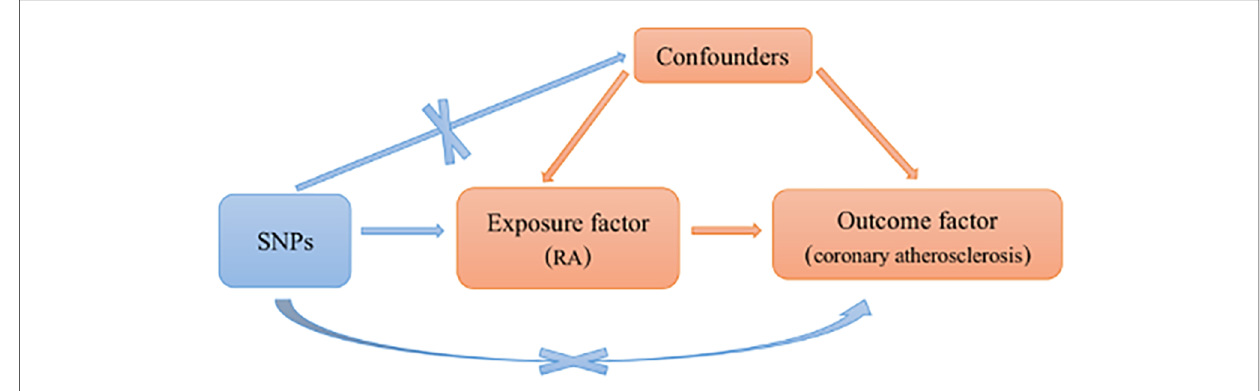
FIGURE 1 Schematic representation of an MR analysis. Three basic assumptions of MR analysis. MR, Mendelian randomization; RA, rheumatoid arthritis; SNPs, single nucleotide